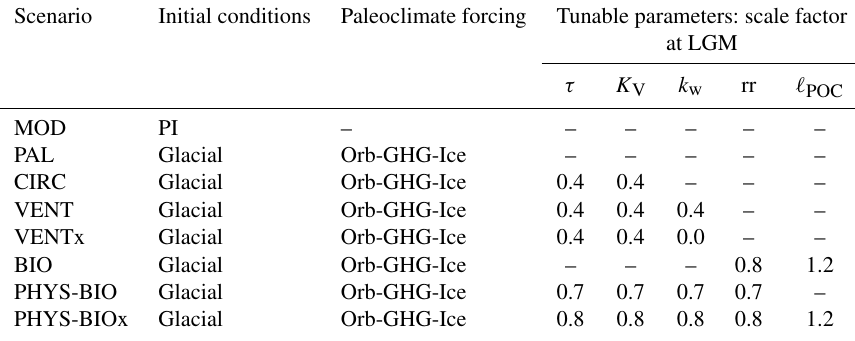
Table 1. Summary of model scenarios considered in this study. Initial conditions refer to the boundary conditions used for the precursor spin-up simulation needed to initialize the transient simulation. These correspond either to preindustrial (PI) or last glacial conditions. The paleoclimate forcing fields, i.e., Orb-GHG-Ice, are reconstructed changes in orbital parameters (Berger, 1978), greenhouse gas radiative forcing based on reconstructed atmospheric greenhouse gas histories (Köhler et al., 2017), and varying ice sheet extent scaled using the global benthic δ 18 O stack of Lisiecki and Stern (2016). Numbers refer to the scale factor values applied to the tunable model parameters τ (wind stress scale factor), K V (vertical diffusivity), k w (gas transfer velocity), rr (CaCO 3 -to-POC export ratio), and (cid:96) POC (POC remineralization length scale) at the Last Glacial Maximum (LGM). These values were chosen in order to achieve an atmospheric CO 2 concentration close to the LGM level and are varied over time using the global benthic δ 18 O stack. See Roth et al. (2014) for the Bern3D model parameter set. In all scenarios, the fully coupled model configuration, including the major global carbon reservoirs (atmosphere, terrestrial biosphere, ocean, and sediments), is